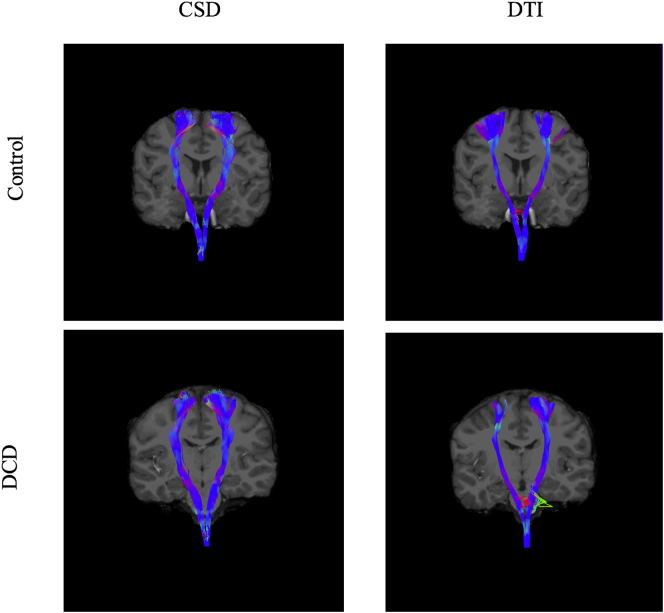
A visual representation of CST tracts using CSD and DTI modelling in a representative individual with DCD and a control participant. NOTE: CST- corticospinal tract; CSD- constrained spherical deconvolution; DTI- diffusion tensor imaging.